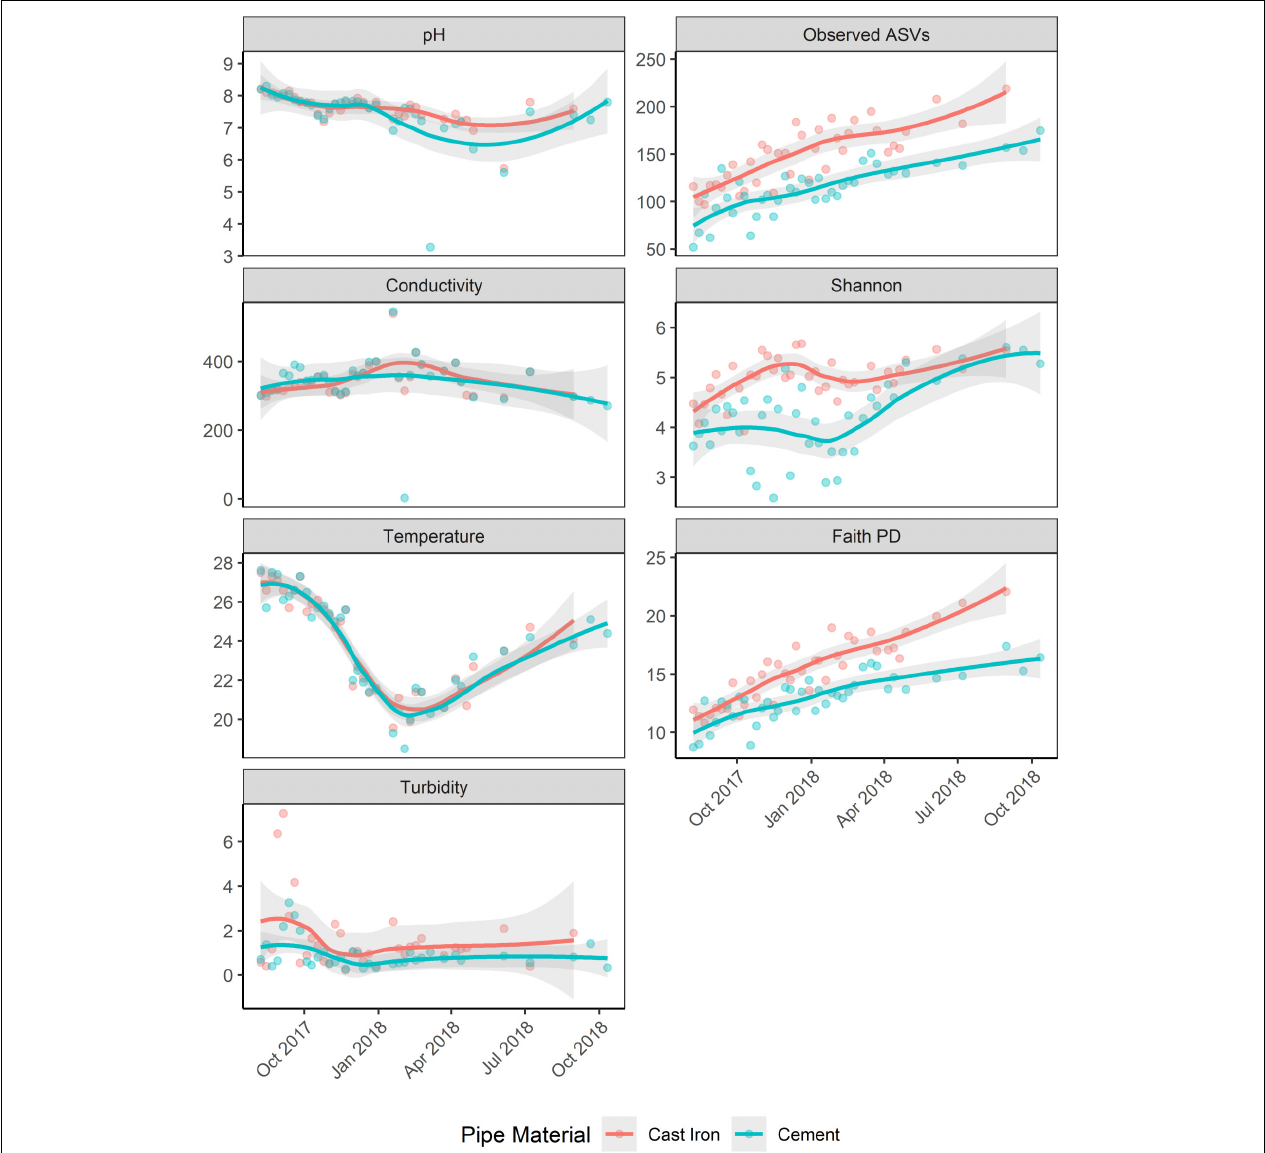
FIGURE 4 | Observed ASVs, Faith PD, and Shannon H indices of biofilm samples from annular reactors (ARs) and physicochemical parameters [pH, temperature (Celsius), conductivity (pS/cm), and turbidity (NTU)] of water samples collected from ARs during coupon collection. For the first 34 weeks, one cast iron coupon and one cement coupon were collected. Then, one cast iron coupon was collected monthly for four more months and one cement coupon was collected monthly for six more months. Loess method used to fit the smooth curve. Gray bands represent the 95% confidence